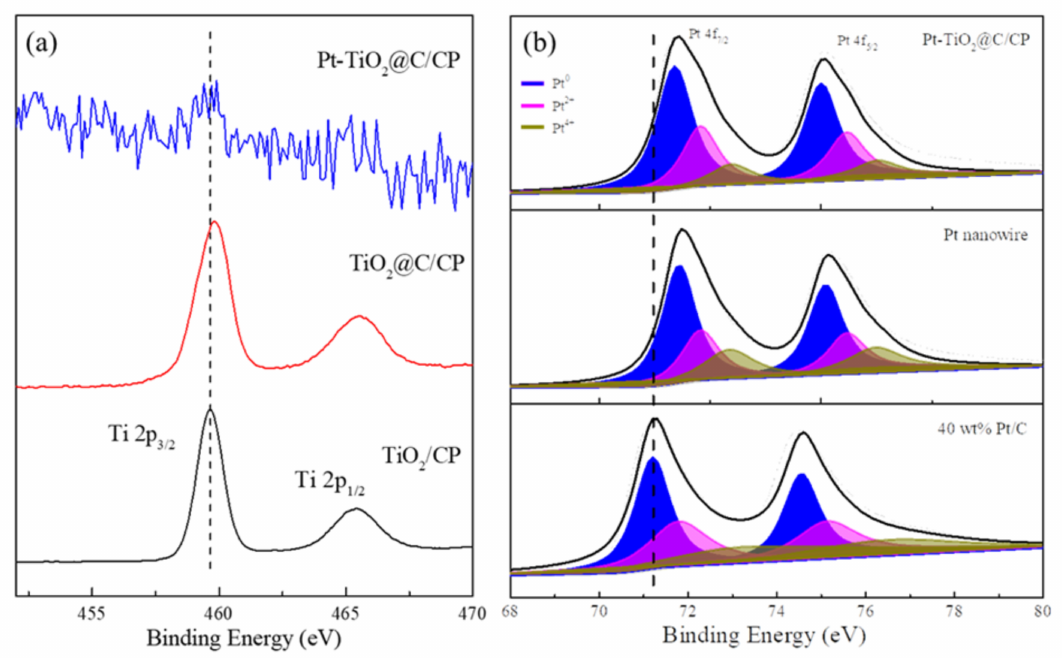
Figure 8. XPS narrow spectra of Ti 2p ( a ) and Pt 4f ( b ) in different